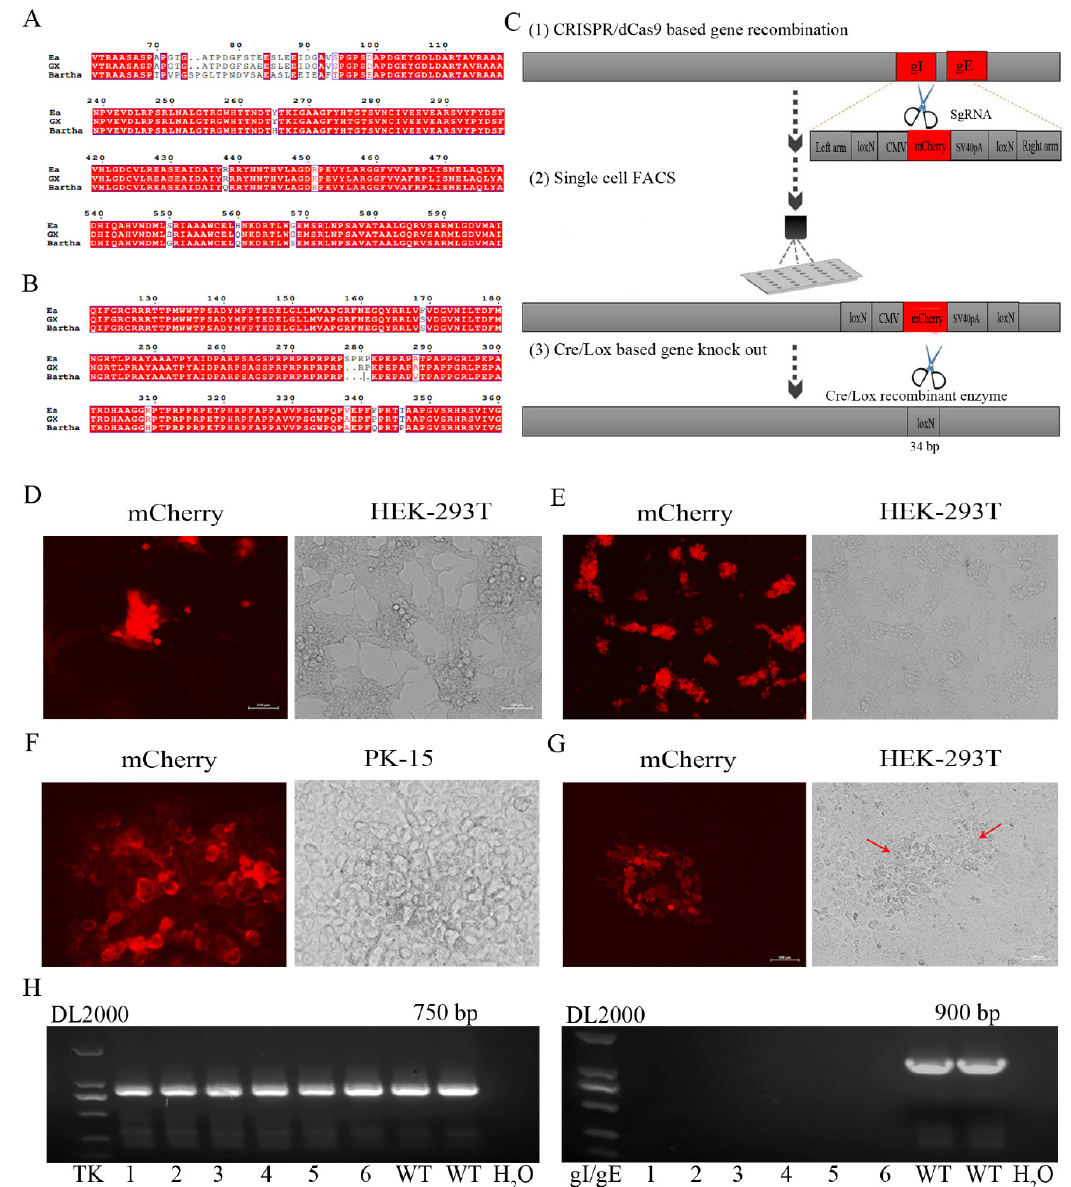
Figure 1. The gE / gI-gene-deleted recombinant PRV (rGX ∆ gE / gI) was developed using CRISPR / Cas9 and Cre / Lox systems. ( A , B ) Amino acid sequence alignments of PRV gB and gD (PRV GX strain, PRV Bartha strain, and the previous pandemic strain PRV Ea). ( C ) The vaccine development strategy was performed. PRV virulent gene gE and gI were replaced with mCherry via CRISPR / Cas9 system-assisted homologous recombination. Recombinant virus purification was accelerated using single-cell FACS. The mCherry gene was deleted through the Cre / Lox system. ( D ) Fluorescence detection was performed when HEK293T cells were co-transfected with pX335-Cas9-sgRNA-gE, pX335-Cas9-sgRNA-gI, gIhm-loxN-CMV-mCherry-SV40polyA-loxN-gEhm donor template and PRV genome. ( E ) Single cells with fluorescent gene recombinant PRV were selected using FACS. ( F ) Plaque purification of gE / gI-gene-deleted recombinant PRV in agarose-DMEM plates. ( G ) Plaque purification for fluorescent gene excision PRV following Cre- recombinase treatment. Arrow indicated cell plaques. ( H ) PCR verification of gE / gI gene deletion.